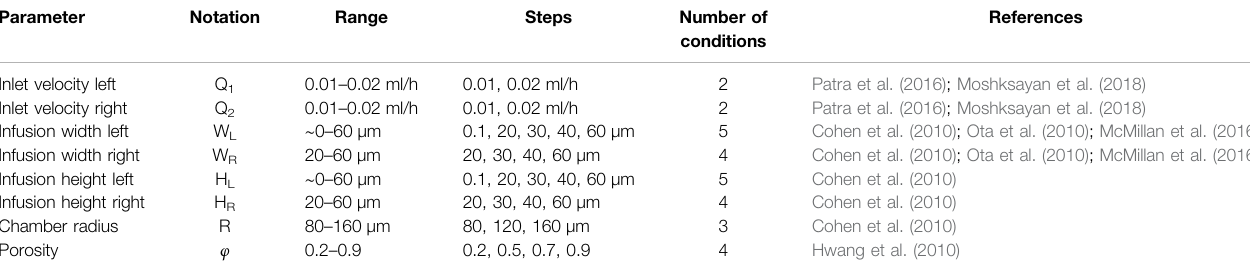
TABLE 1 | Geometrical, material, and operating conditions used in current spheroid-on-a-chip design study.